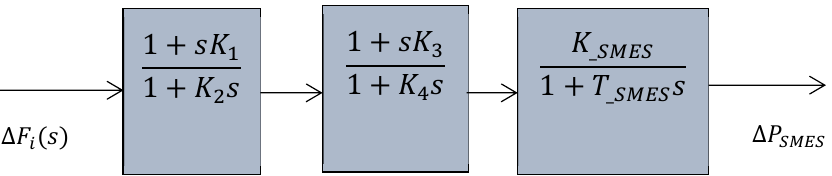
Figure 3. Modelling of SMES as a frequency controller .